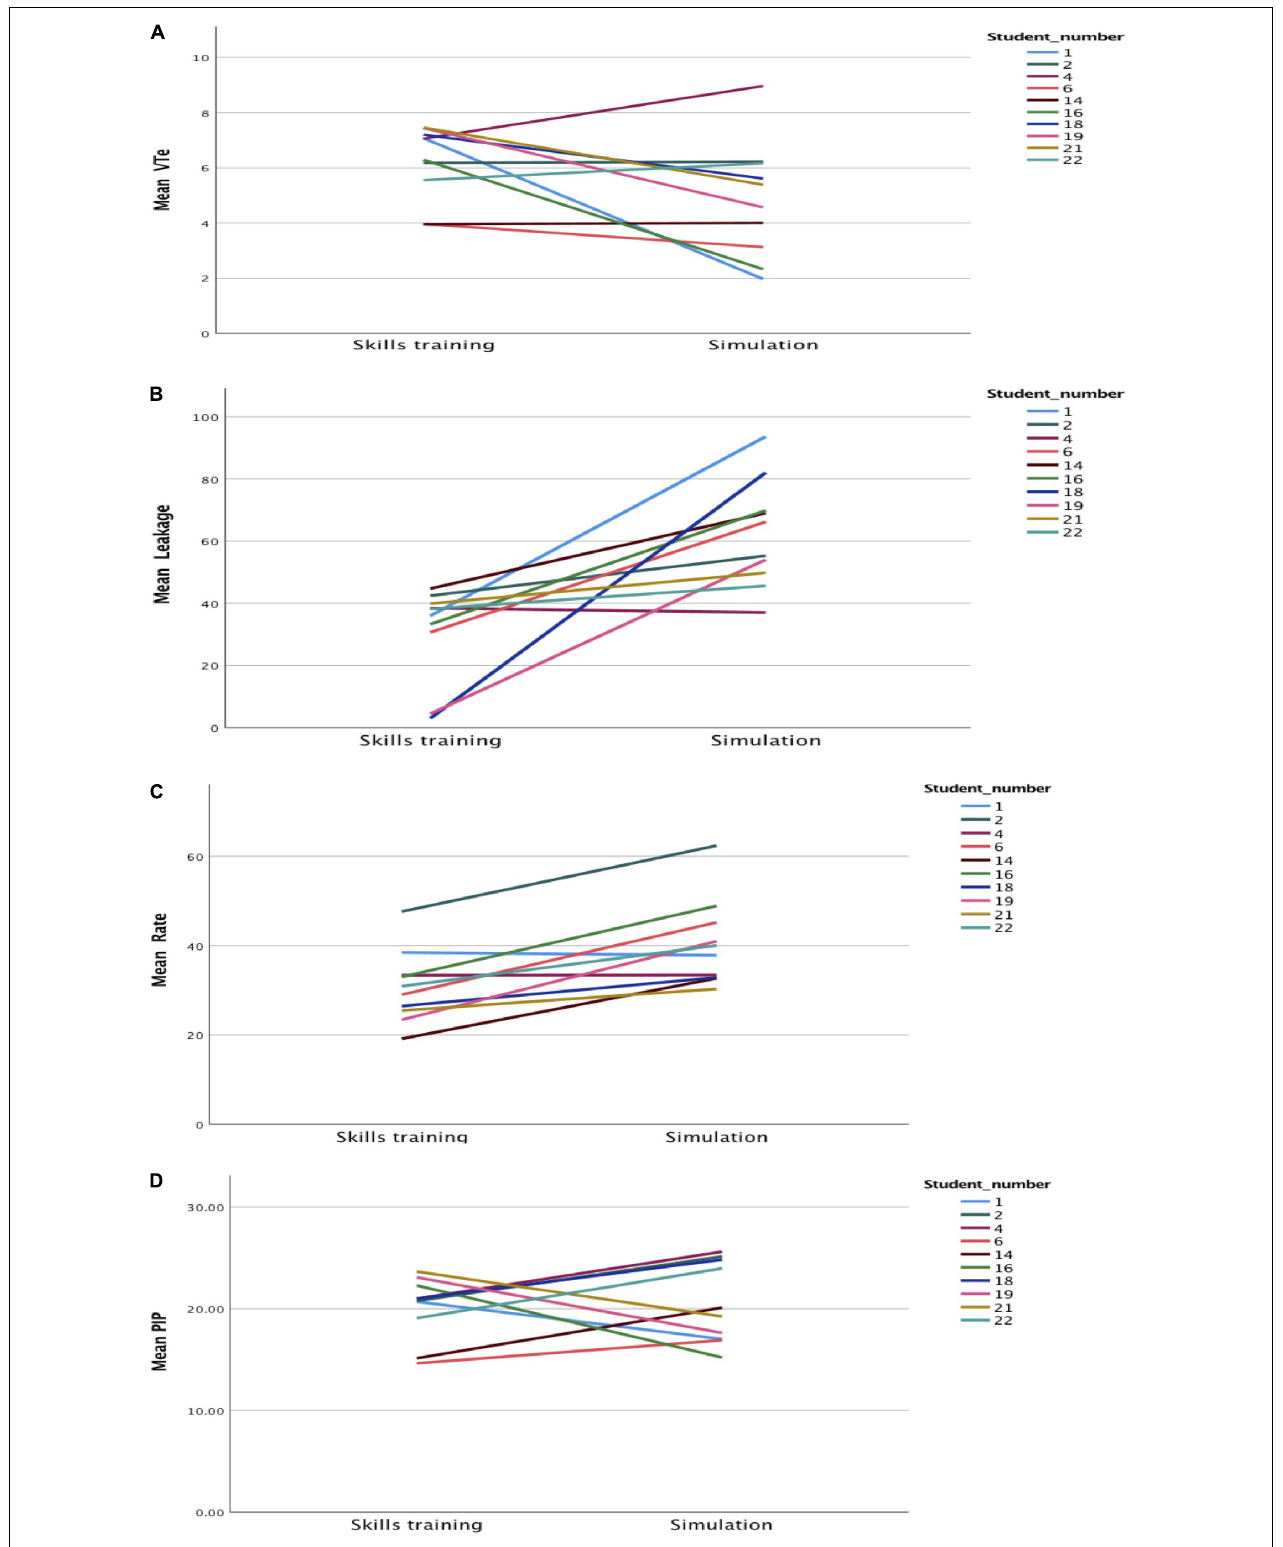
FIGURE 3 | Spaghetti plots individual students of (A) expiratory tidal volume (VT e , ml/kg), (B) leakage (%), (C) ventilation rate (min − 1 ), and (D) positive inspiratory pressure (PIP, cmH 2 O) during skills and simulation